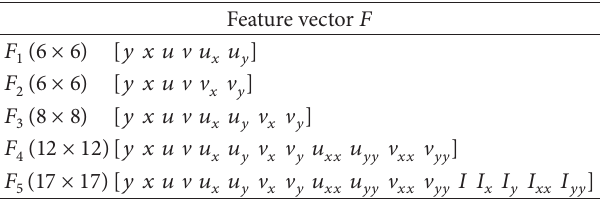
Table 1: Different choices of feature 𝐹 to construct the covariance